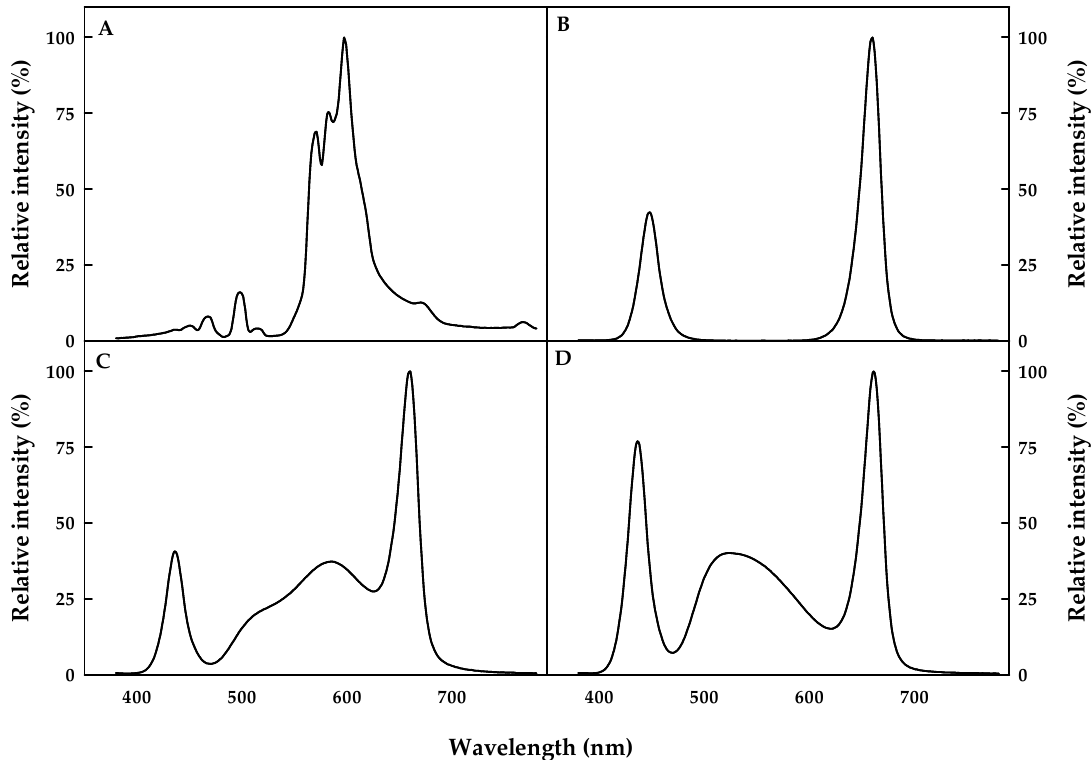
z HPS, high-pressure sodium lamps; NSL, narrow-spectrum LEDs; SFL, specific full-spectrum or W light sources.